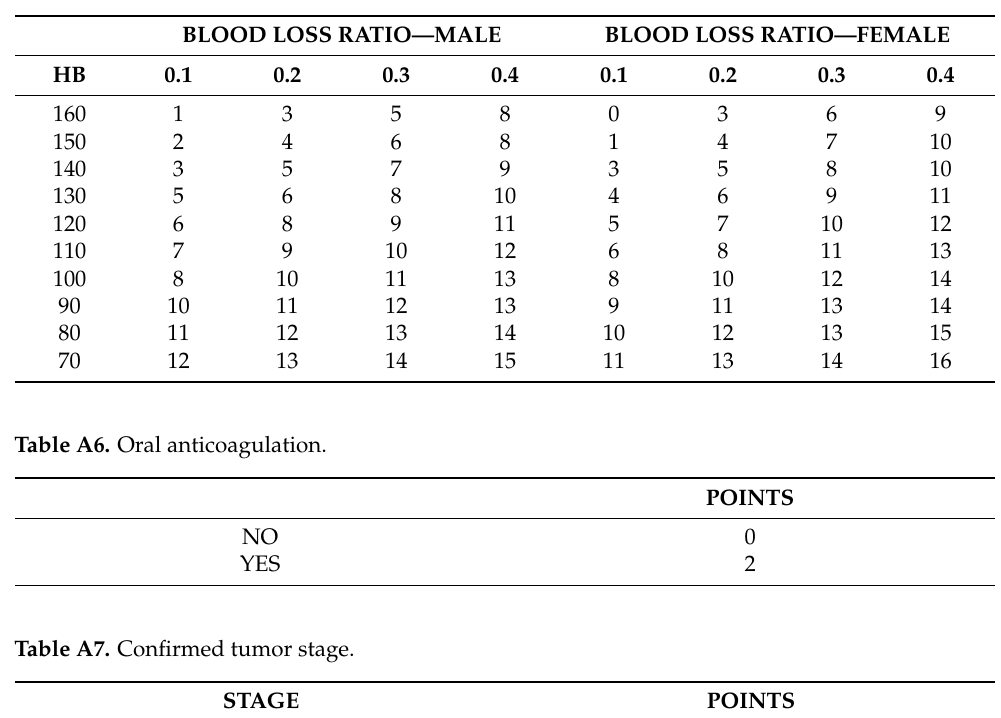
Table A5. Preoperative hemoglobin—Blood loss ratio—Sex.